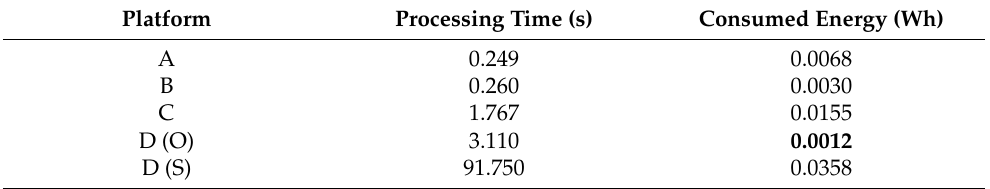
Table 3. Comparison of the energy efficiency of the platform; the lowest value of Energy was marked by bold. Platform Processing Time (s) Consumed Energy